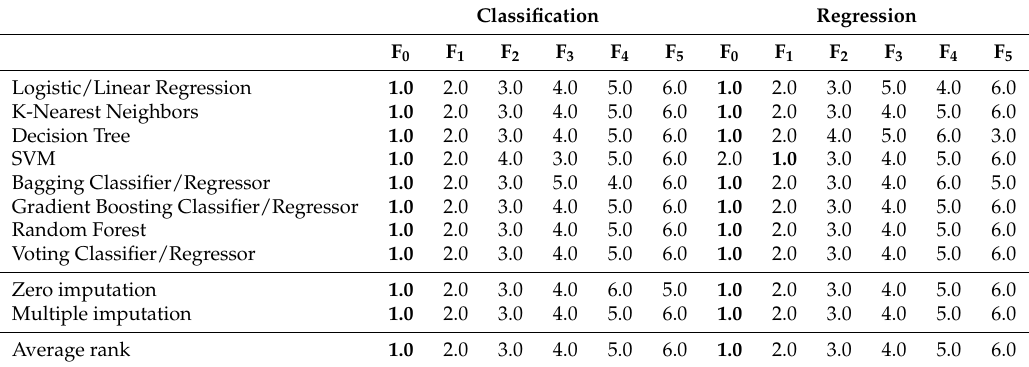
Table 5. Rankings of feature sets for different classification and regression models for